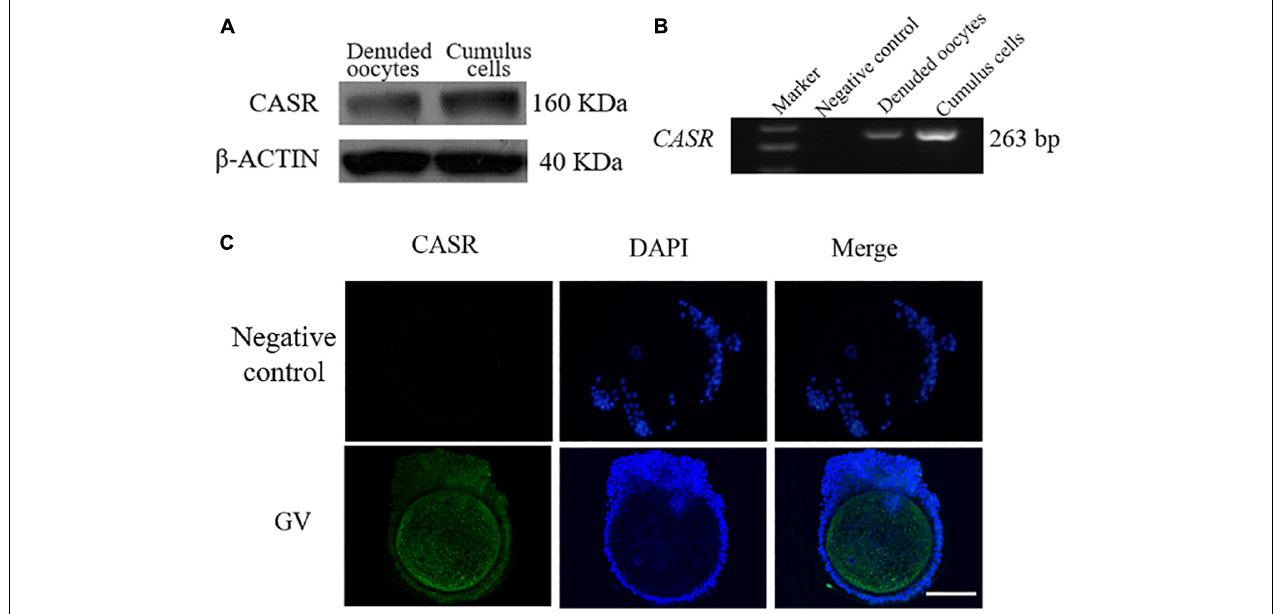
FIGURE 1 | Expression and localization of CASR in porcine cumulus cells. Cumulus-oocyte complexes (COCs) or oocytes in the germinal vesicle (GV) stage (intact nucleus) were used immediately after collection. Identification of CASR protein (A) and mRNA (B) in porcine cumulus cells and denuded oocytes; negative control without cDNA. (C) Immunofluorescence results showed that CASR protein (green) was expressed in cumulus cells of porcine COCs. Chromatin was stained with DAPI (blue). Negative controls show no staining for CASR. In the negative control group, the first antibody was replaced by 2% BSA, with the other steps being the same. Scale bar = 50 µ m. CASR, Calcium-Sensing